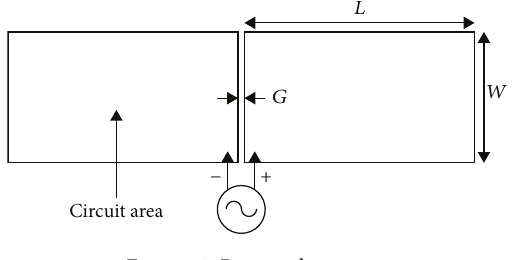
Figure 1: Proposed antenna.